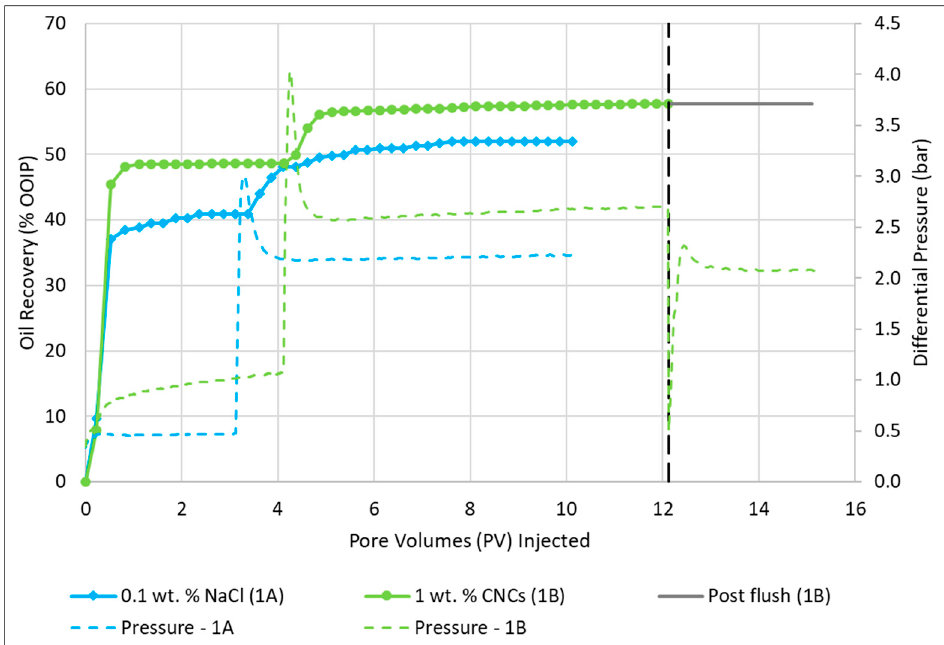
Figure 5. Oil recovery and pressure curves for secondary water flood (Test 1A) and secondary CNC nano flood (Test 1B). The black dotted vertical line indicates where post water flush was initiated for the nano flood. The spike in pressure curves indicates where the rate was switched from 0.3 mL / min to 3.0 mL / min, for the respective floods.